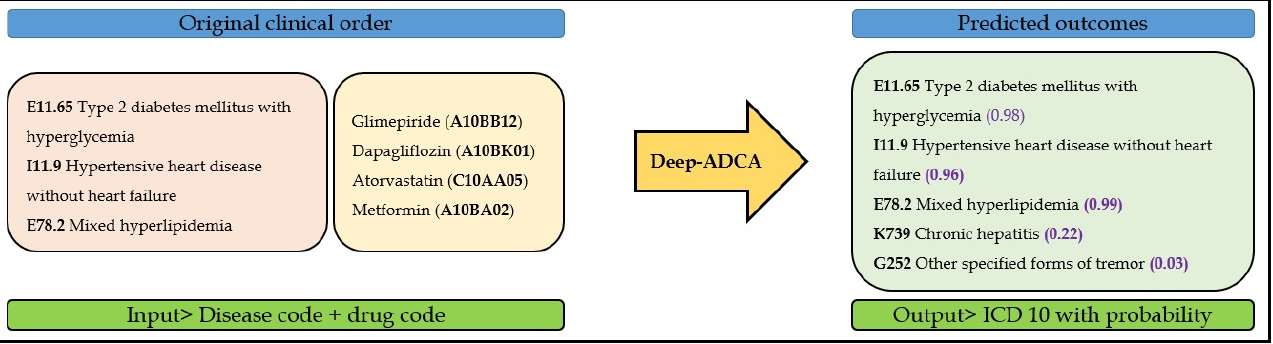
Figure 7. Probabilities of ICD-10 codes predicted from given inputs.